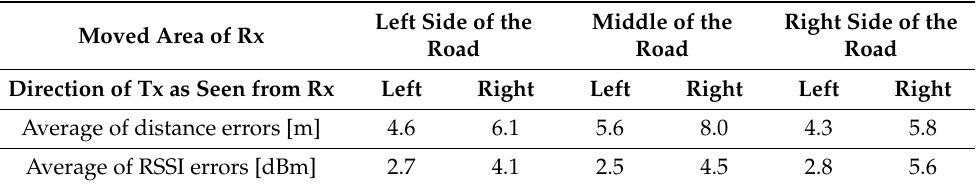
Table 1. Position estimation error results of actual measurement on the T-shape road (direction of Tx as seen from Rx is left: Tx Point 1~9, direction of Tx as seen from Rx is right: Tx Point 10~18). Left Side of the Middle of the Right Side of the Moved Area of Rx Road Road Road Direction of Tx as Seen from Rx Left Right Left Right Left Right Average of distance errors [m] 4.6 6.1 5.6 8.0 4.3 5.8 Average of RSSI errors [dBm] 2.7 4.1